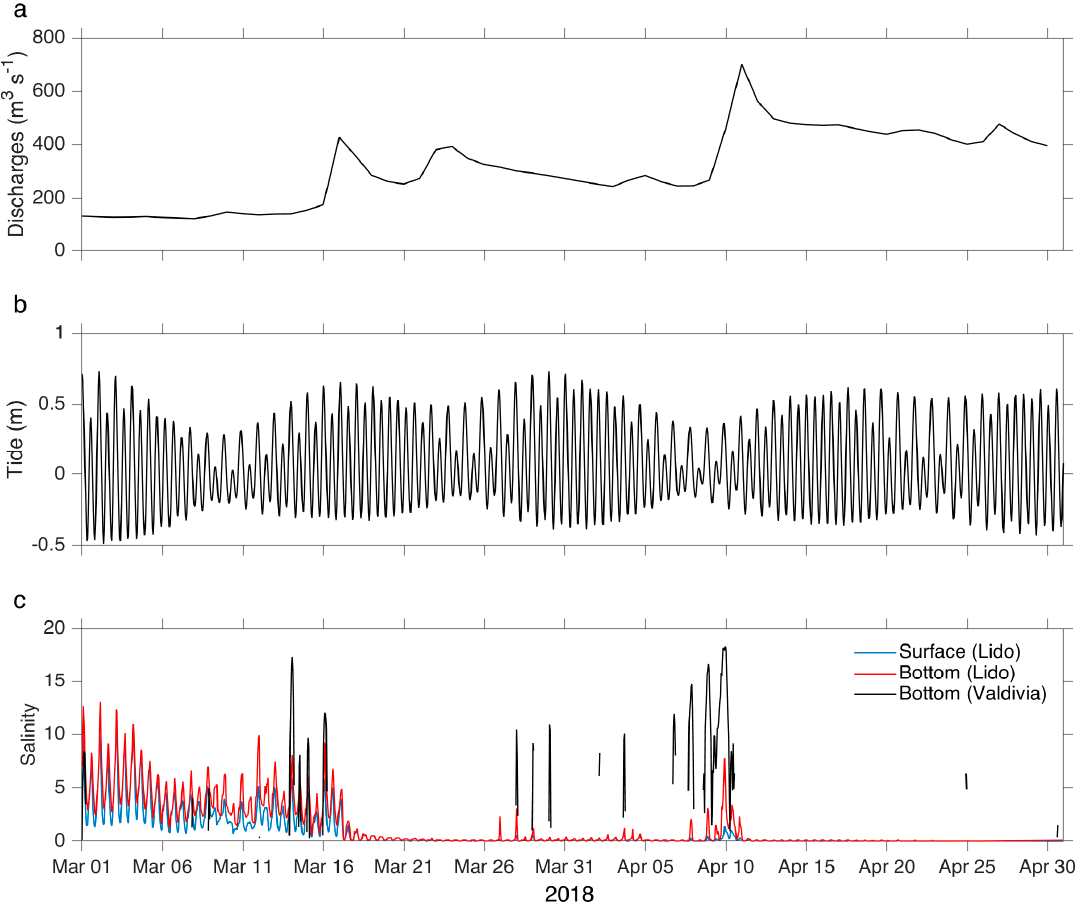
Figure 5. Hourly time series during March and April 2018. ( a ) Sum of the daily flows of the Calle-Calle and Cruces rivers; ( b ) reconstruction of the hourly astronomical tide at the Lido station; and ( c ) bottom (3 m, red line) and surface (blue line) hourly salinity at Lido, and bottom (8 m, black line) hourly salinity at Valdivia.